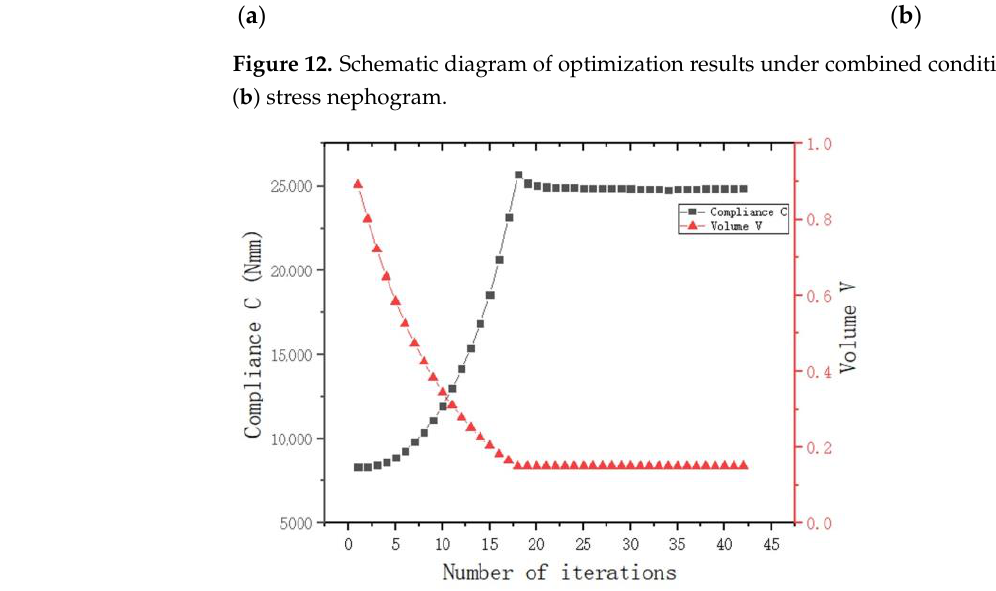
Figure 13. Optimization process under combined working conditions (the black dotted line is the change curve of compliance C, and the red dotted line is the volume-reduction curve).